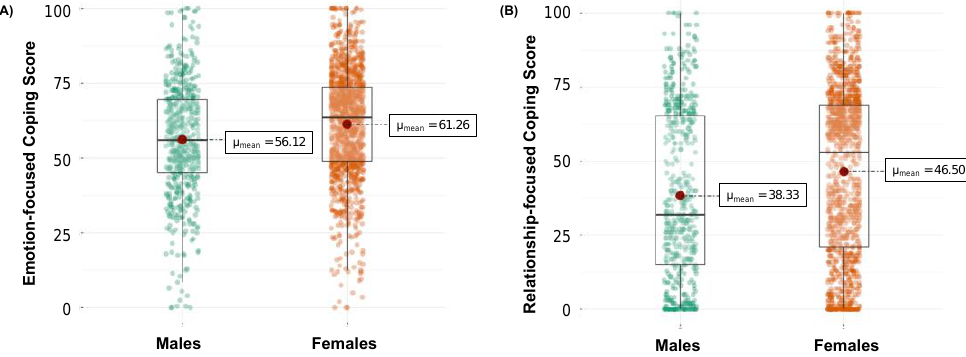
Figure 2. Gender difference in ( A ) emotion- and ( B ) relationship-focused coping.